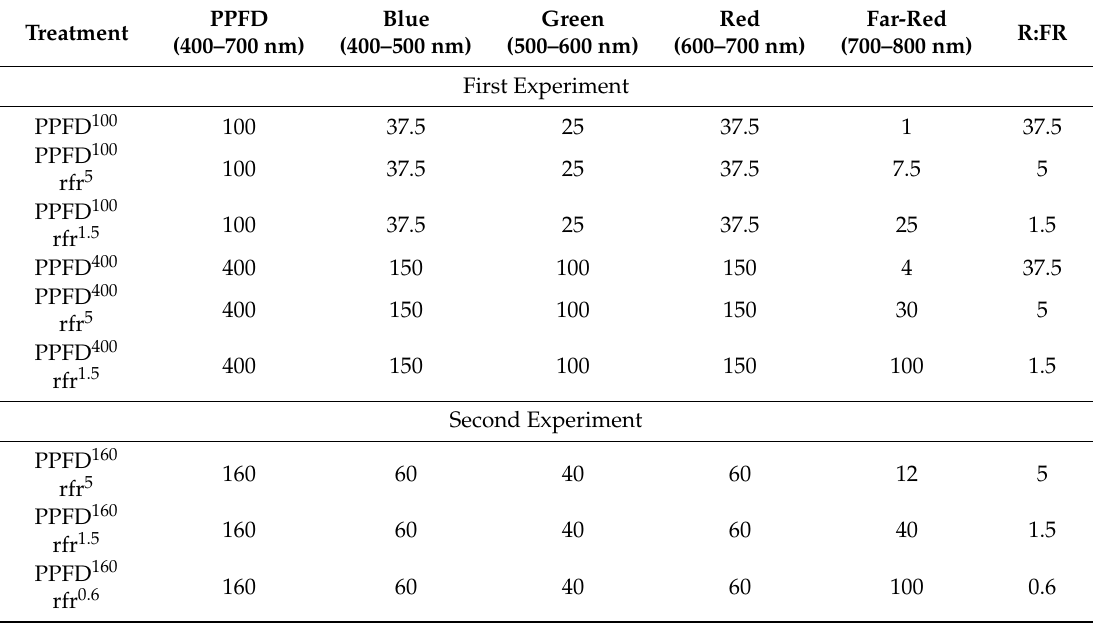
Table 1. Photon flux density ( µ mol m − 2 s − 1 ) within the four-color ranges, total photosynthetic photon second